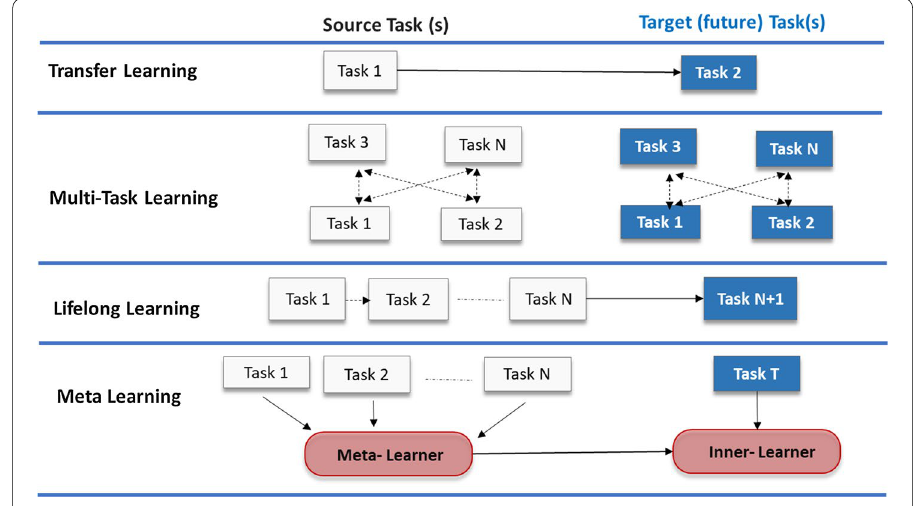
Fig. 8 Knowledge sharing methods